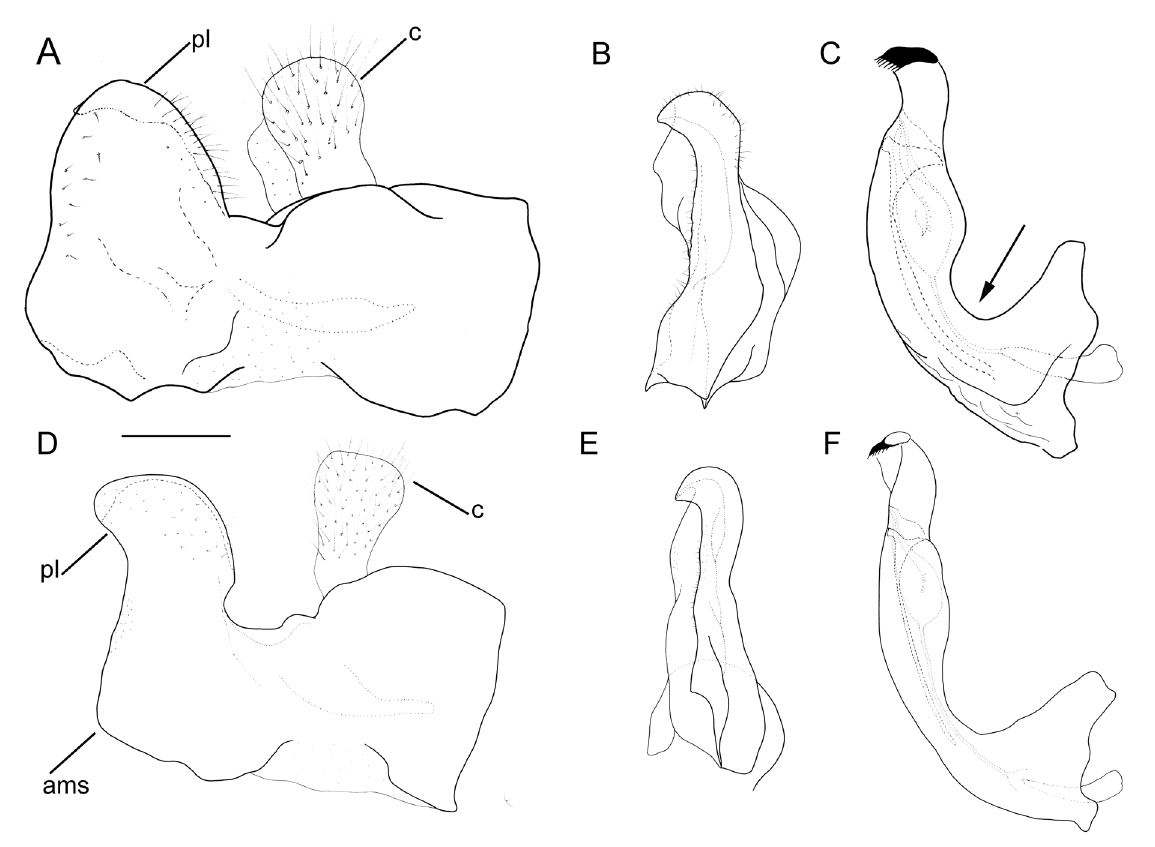
Fig. 13. Male genitalia. A–C . Merodon bombiformis Hull, 1944 (NMSA; FSUNS ID 04277). D–F . M. multifasciatus Curran, 1939 (NMSA; FSUNS ID 04284). A, D . Epandrium, lateral view. B, E . Epandrium, ventral view. C, F . Hypandrium, lateral view. Abbreviations: ams = anterior margin of surstyle; c = cercus; pl = posterior lobe of surstyle. Medially narrowed hypandrium marked with arrow. Scale bar = 0.5